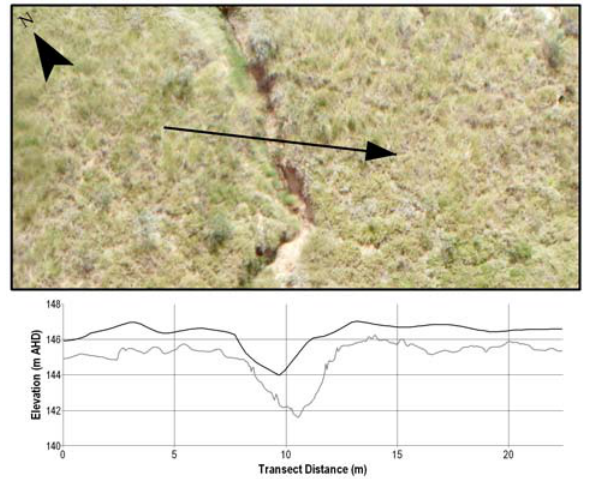
Figure 3. Erosion gully in study site area and corresponding surface elevations along transect (Method One grey, Method Two